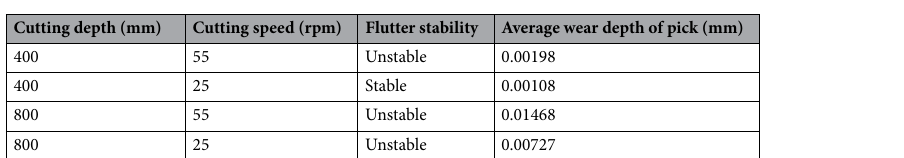
Table 6. Average wear depth of pick with different cutting